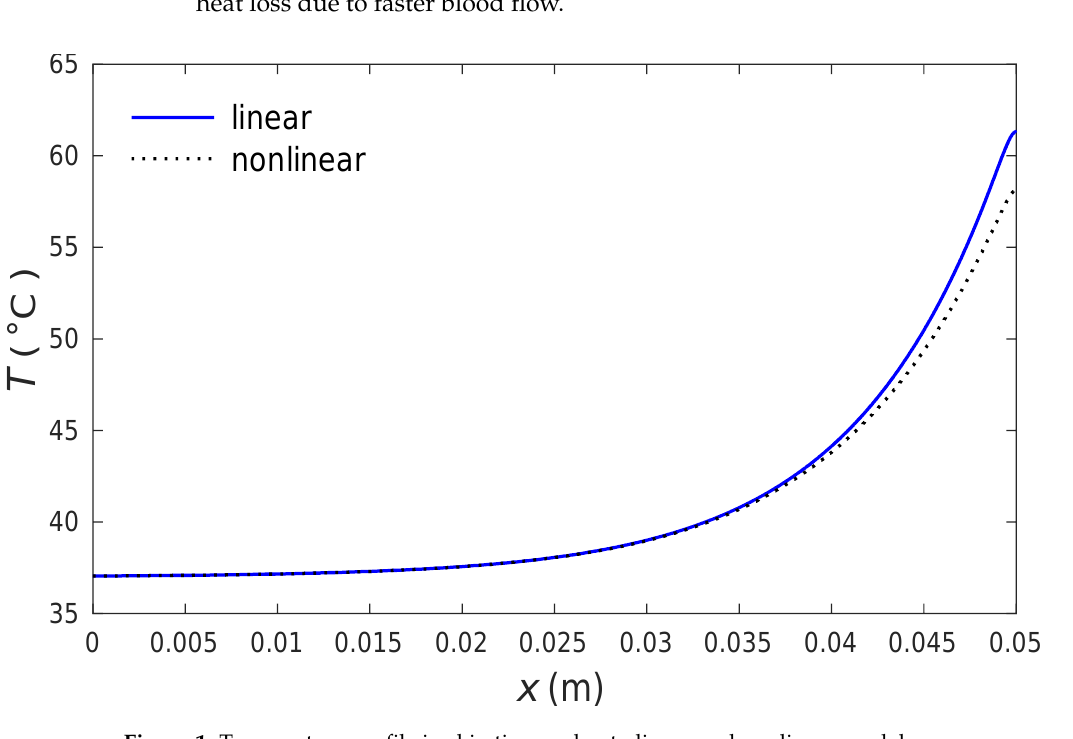
Figure 1. Temperature profile in skin tissues due to linear and nonlinear models.